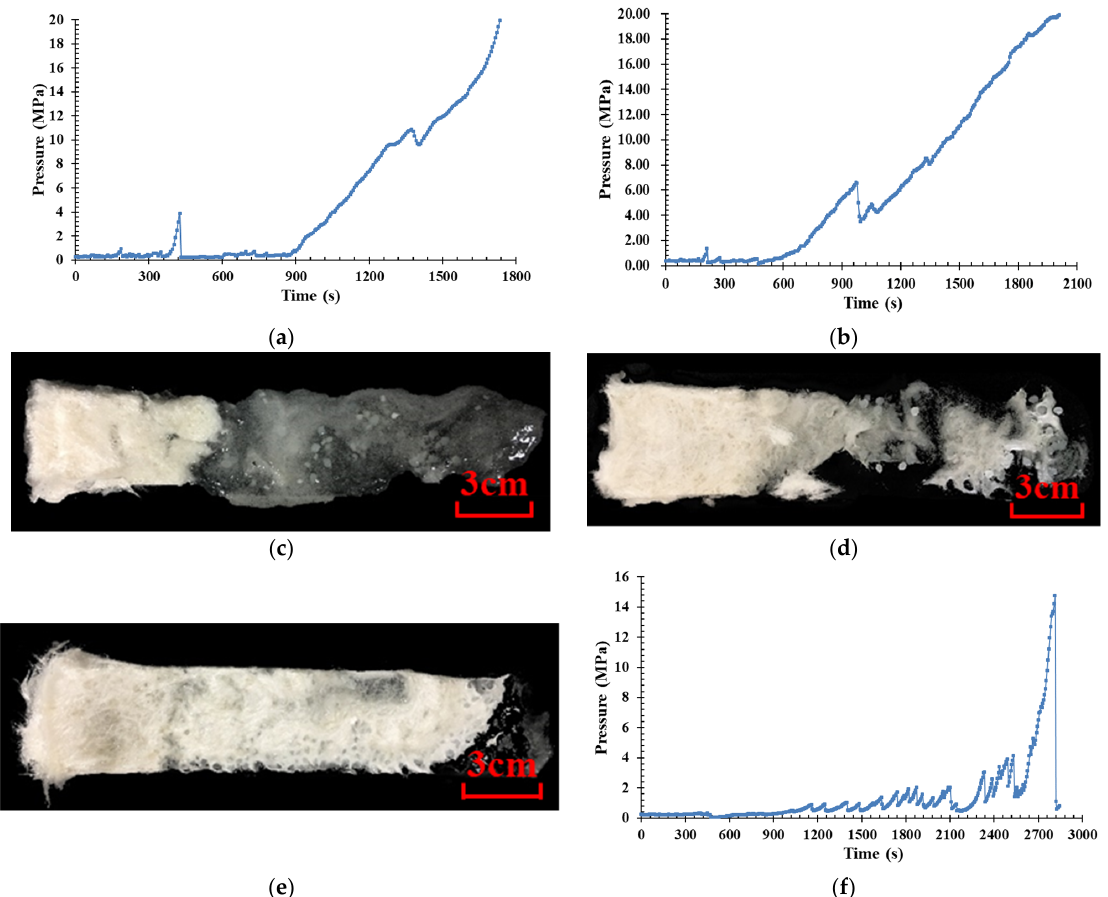
Figure 7. Pressure curve and temporary plugging zone morphology of experiment 6–8. ( a ) Pressure curve of experiment 6; ( b ) Pressure curve of experiment 7; ( c ) Temporary plugging zone morphology of experiment 6; ( d ) Temporary plugging zone morphology of experiment 7; ( e ) Temporary plugging zone morphology of experiment 8; ( f ) Pressure curve of experiment 8.